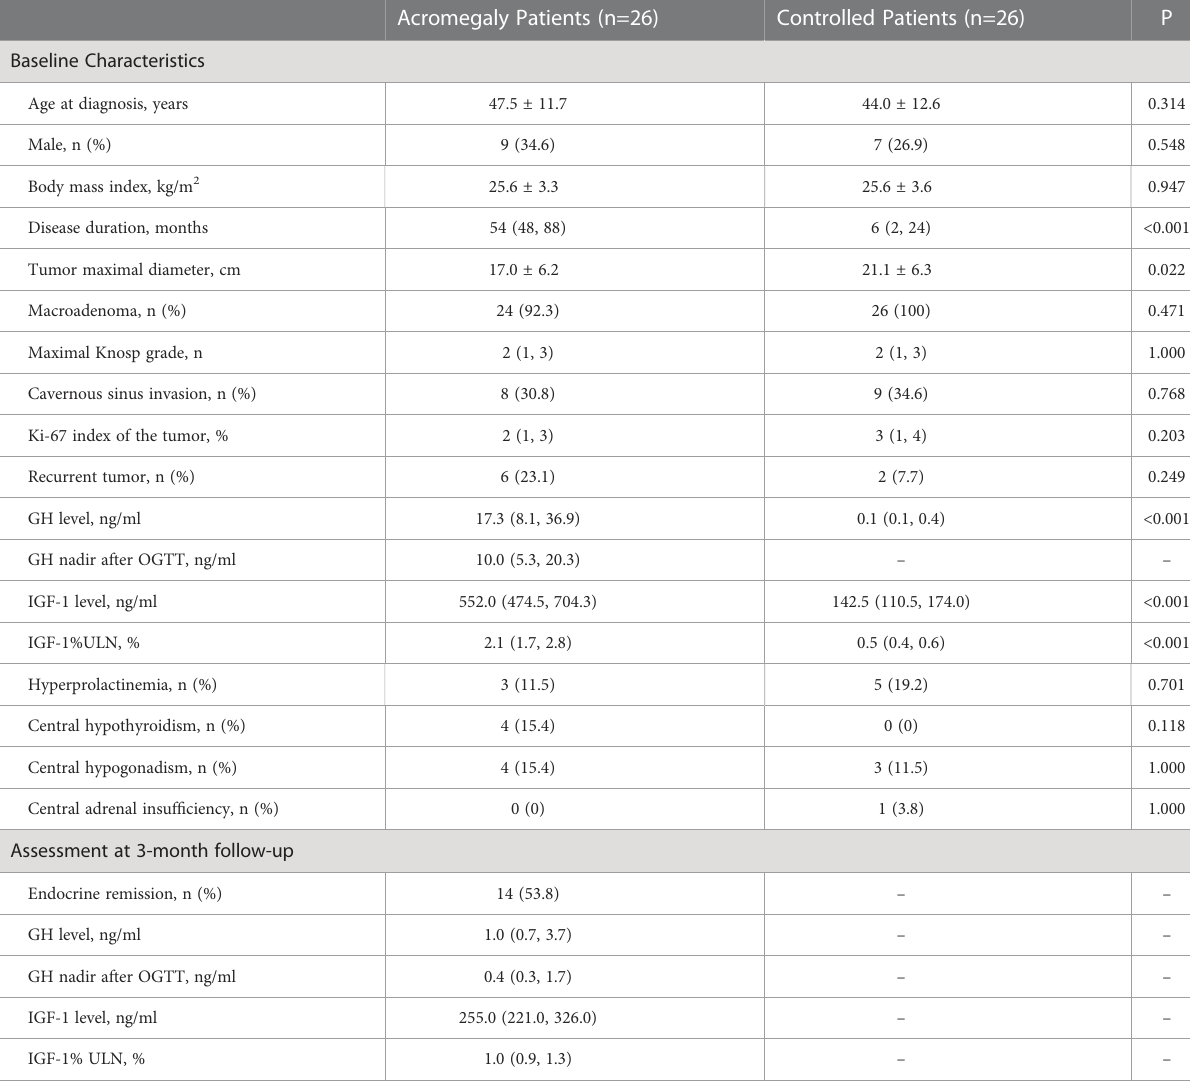
TABLE 1 Clinical characteristics of acromegaly patients and the